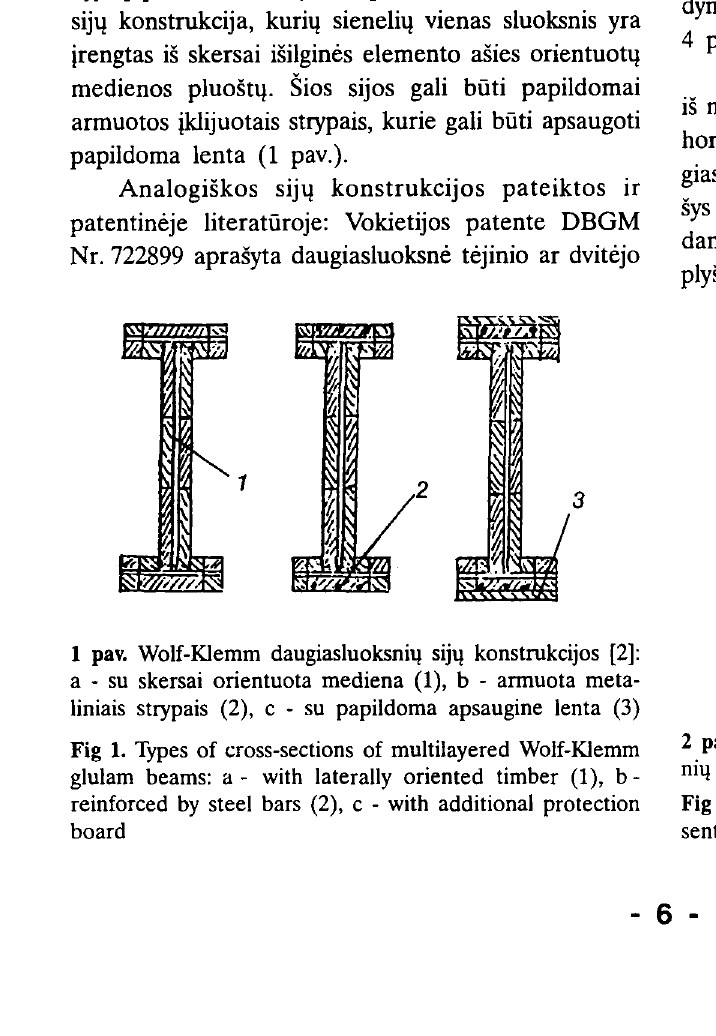
Fig 1. Types of cross-sections of multilayered Wolf-Klemm glulam beams: a - with laterally oriented timber (1 ), b - reinforced by steel bars (2), c - with additional protection board